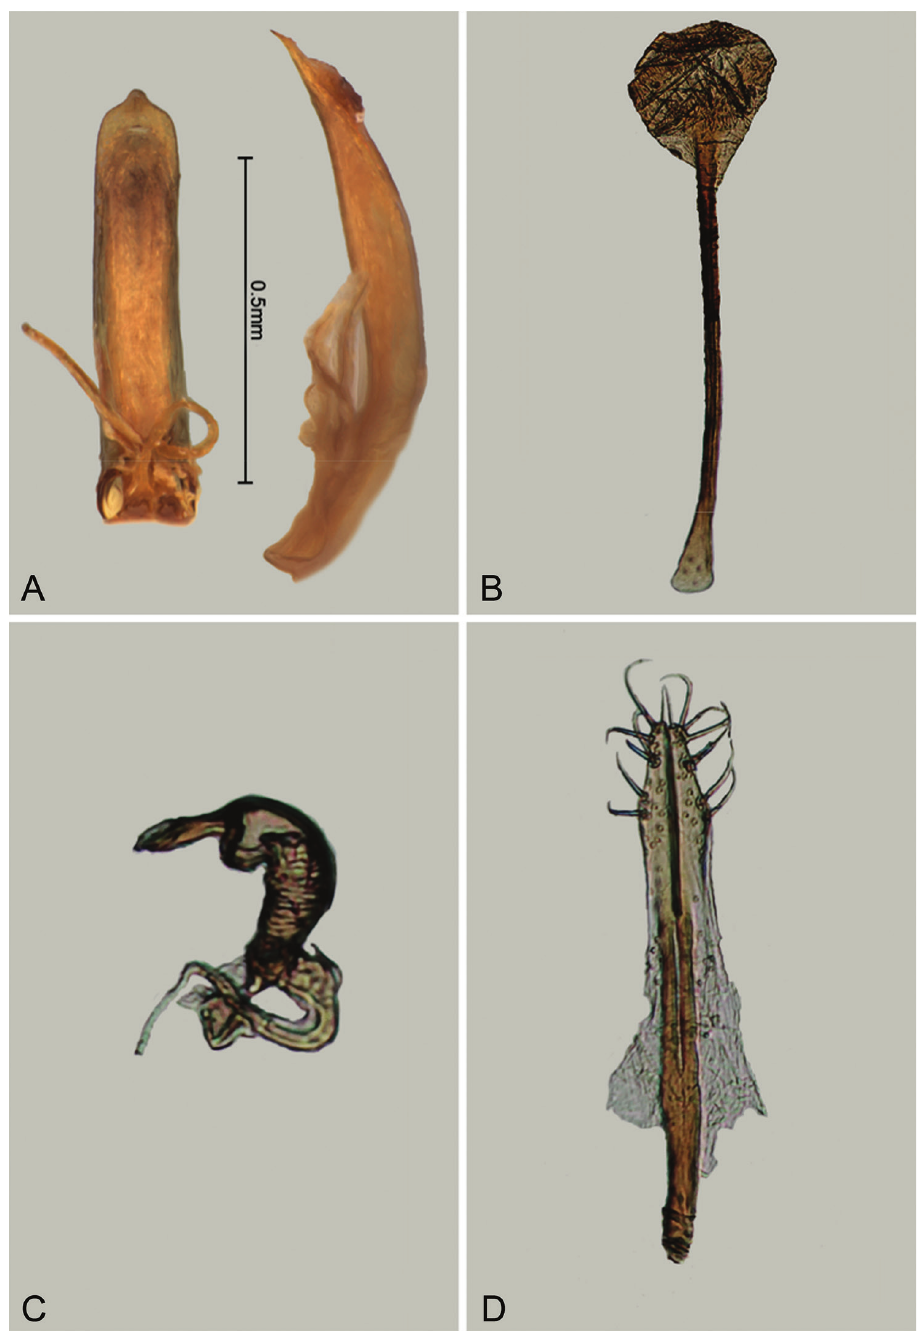
Figure 35. Andersonoplatus saviniae . A Median lobe of aedeagus, ventral and lateral views B Tignum C Spermatheca D Vaginal